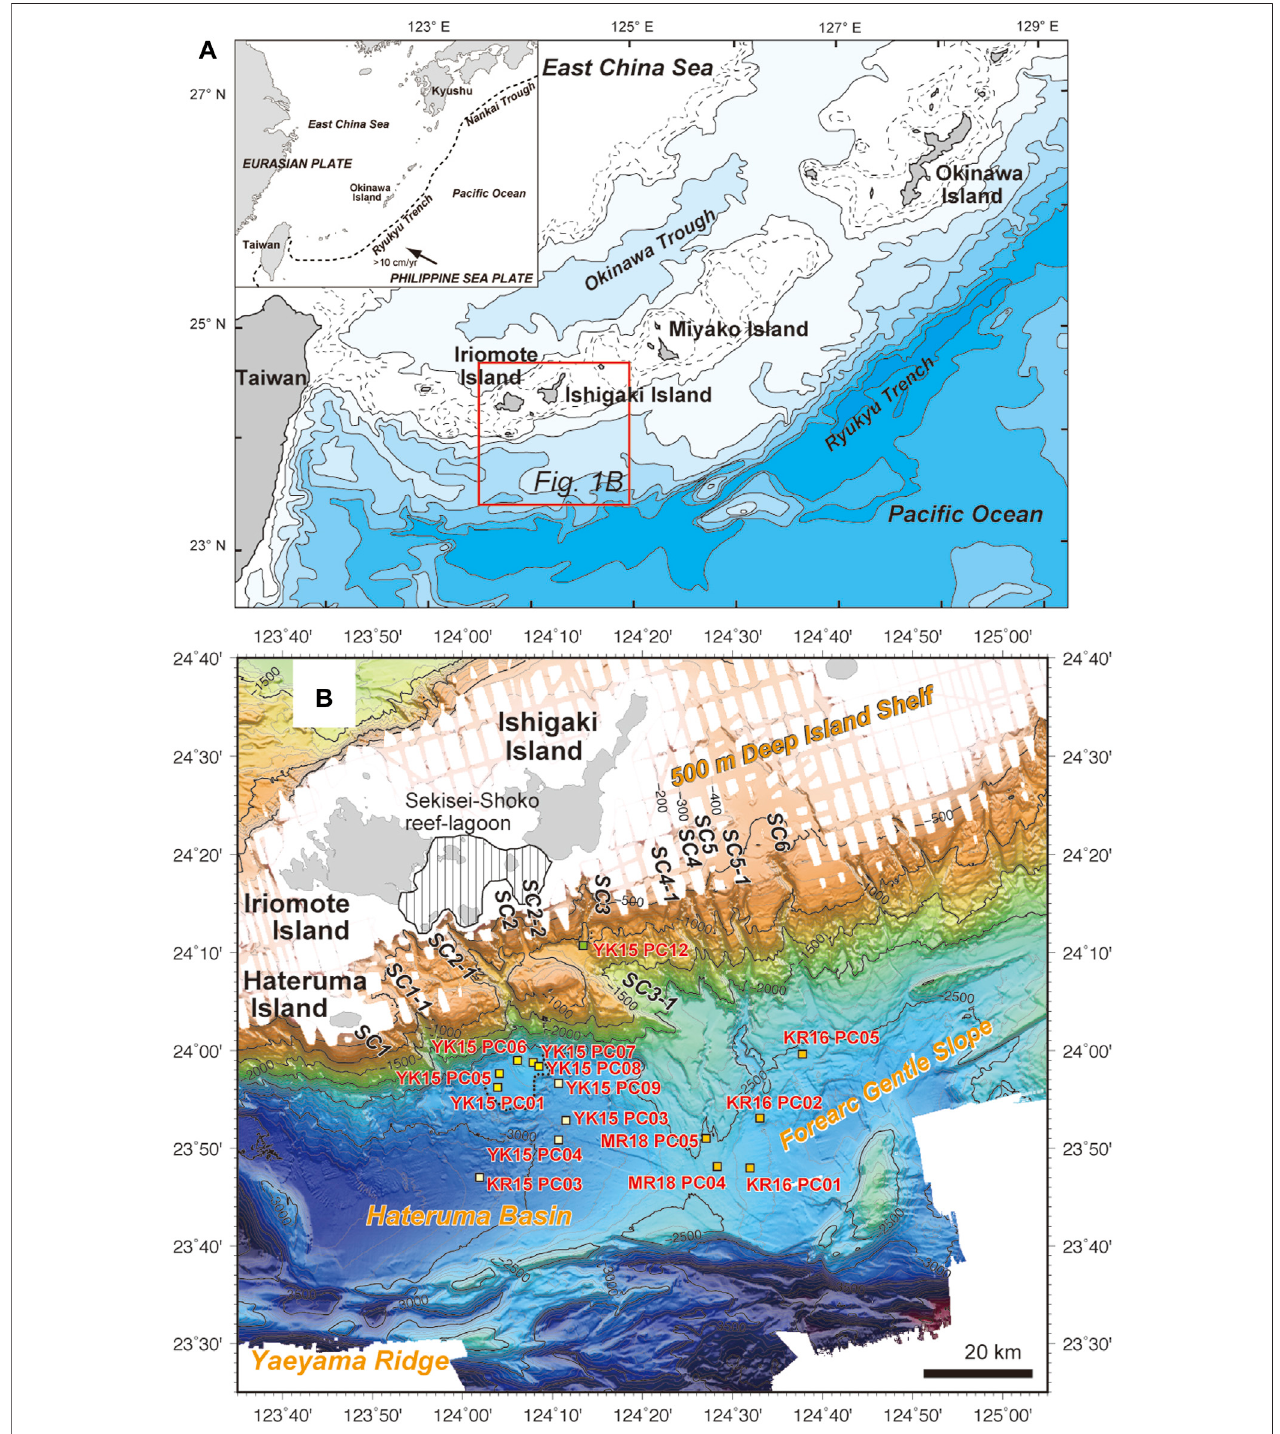
FIGURE 1 | Location (A) and bathymetry (B) of the study area with piston coring locations. SC means submarine canyon listed in Supplementary Table S4 .